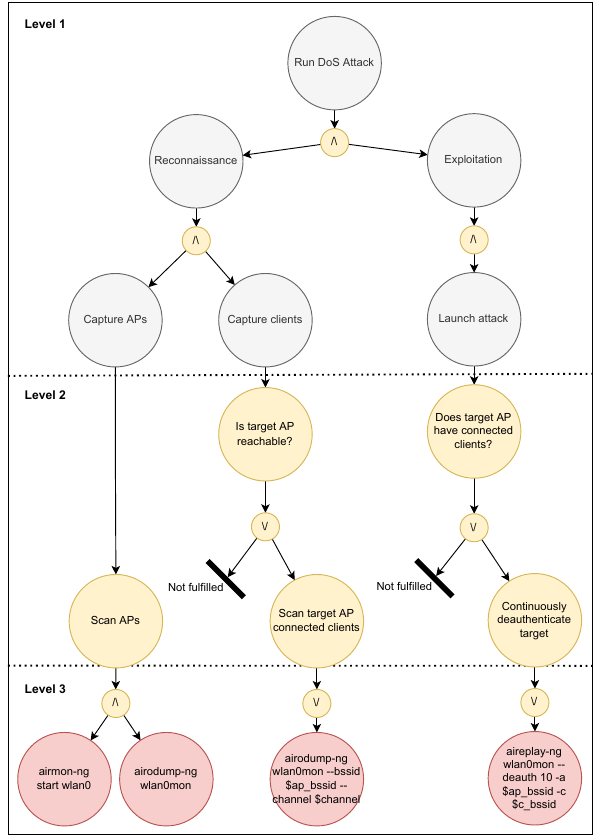
Figure 15. EP model of the DOS